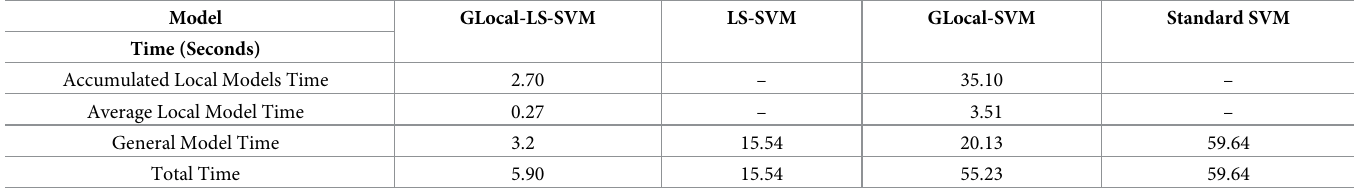
Table 8. Comparing the average time performance, in seconds, of the GLocal-LS-SVM model to the global LS-SVM model, Glocal-SVM, and standard SVM applied to the Pima Indians diabetes dataset.